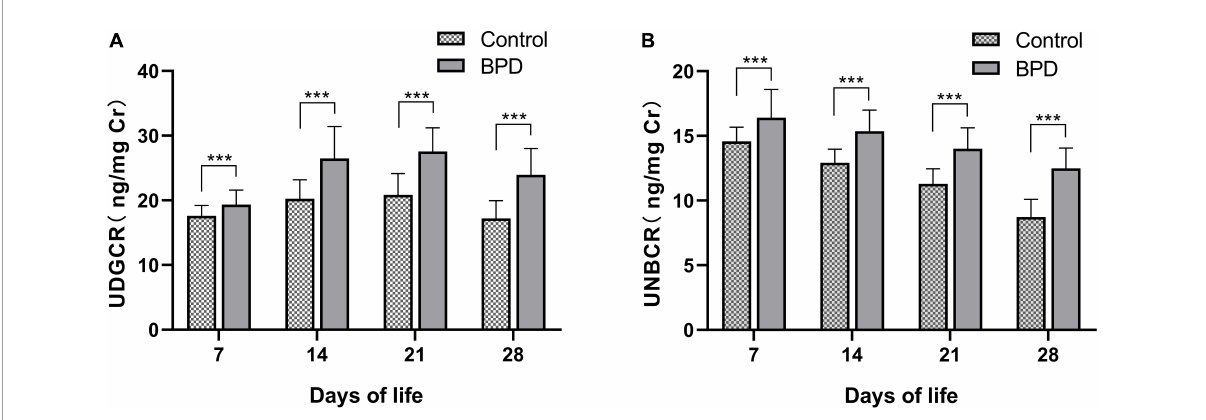
FIGURE1 Urinary 8-OHdG (A) and NT-proBNP (B) levels between two groups. 8-OHdG, 8-hydroxy-2’-deoxyguanosine; NT-proBNP, N-terminal pro-brain natriuretic peptide; UNBCR, urinary NT-proBNP/creatinine ratio; UDGCR, urinary 8-OHdG/creatinine ratio. *** P < 0.001.